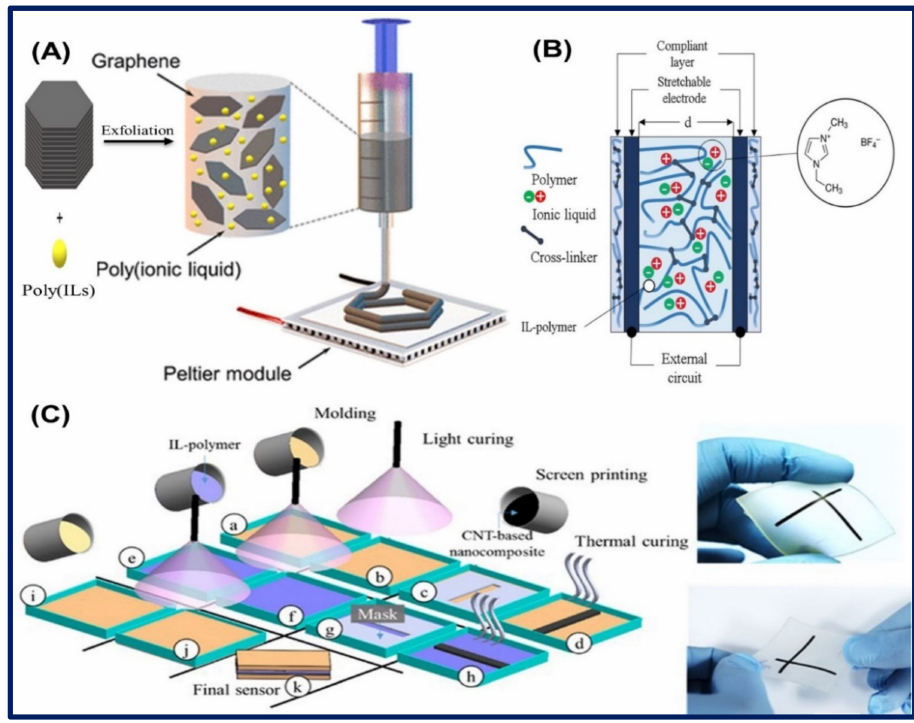
Figure 9. Schematic illustration of the ( A ) freeze 3D printing process. Reprinted with permission from Ref. [78]. Copyright 2020, American Chemical Society. ( B ) Cross-linked ILs/polymer sandwiched between two CNT/polymer electrodes and covered with compliant polymer layers and the chemical structure of (EMI)(BF 4 ) used as an IL. ( C ) Left: Schematic of a hybrid manufacturing process including molding and casting (a, e, i), photocuring (b, f, j), screen printing (c, g), and thermal curing (d, h) to fabricate the suggested sensor. Right: fabricated stretchable sensor. Reprinted with permission from Ref. [79]. Copyright 2016, AIP